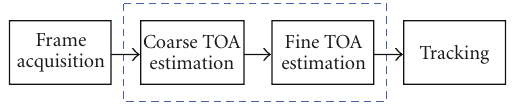
Figure 1: Block diagram for TOA estimation. The algorithm in this paper focuses on the blocks in the dashed